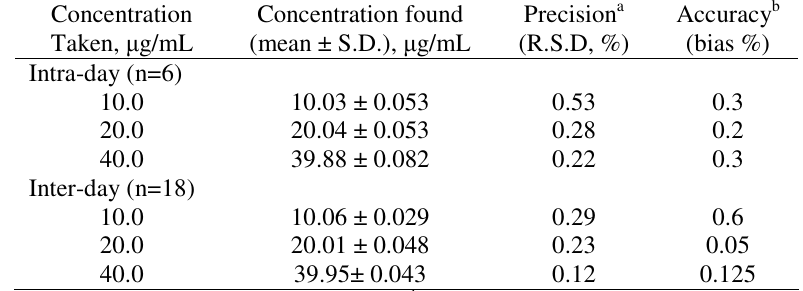
Table 2. Precision and accuracy of method for determination of esmolol hydrochloride (n=18; six sets for 3d